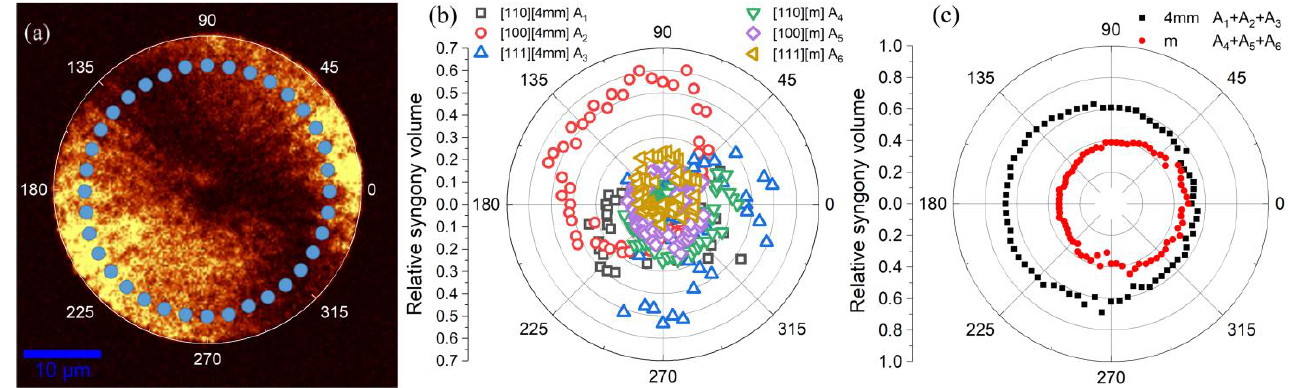
Figure 2. PZT/ST-50 550 : ( a ) — Nonlinear optical microscopic image of a spherulite at a specified angle of polarizer and analyzer. The blue dots show the measured areas of the azimuthal dependencies. In the following, these spots are denoted by their polar coordinate according to the figure. ( b ) — Relative volume of each syngony/orientation depending on the polar coordinate of the region under study. ( c ) — Relative volume of tetragonal and monoclinic phases (contributions of orientations are summed) depending on the polar coordinate of the region under study. Glassceram substrate.